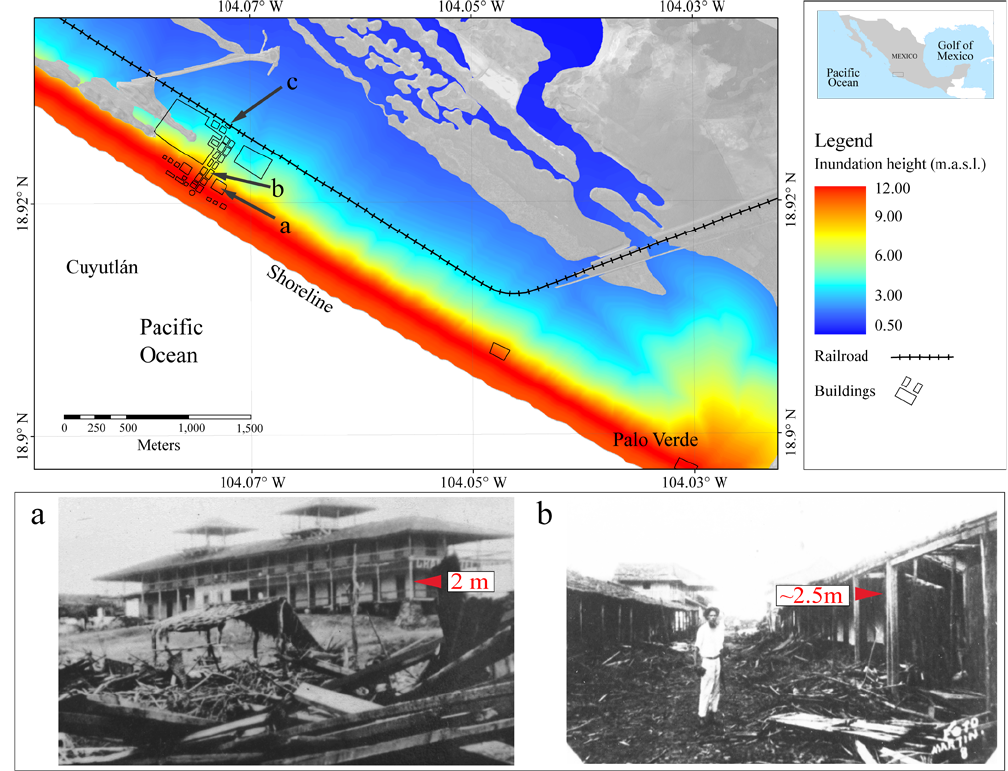
Fig. 7. Inundation height distribution model of the 22 June 1932 tsunami; (a) Madrid Hotel; (b) Main Street (El Informador, 1932c); (c) Train